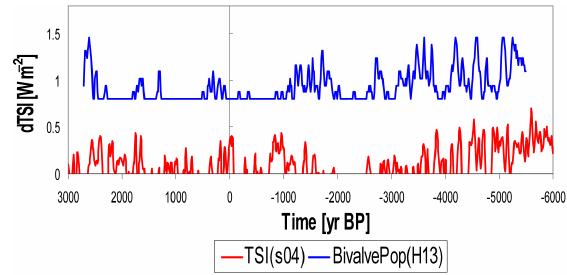
Figure A2. Comparison of bivalve population (BVp) and TSI ad- justed with a linear transformation [TSIadj = TSI + a ( t − t 1 ) + b ] with a = 0 . 03 [Wm − 2 ]/1000[yr] and b =− 0.3 [Wm − 2 ]. Only pos- itive TSI adjusted anomalies are displayed in order to enhance the match and show a possible threshold provided by TSI for BVp de-